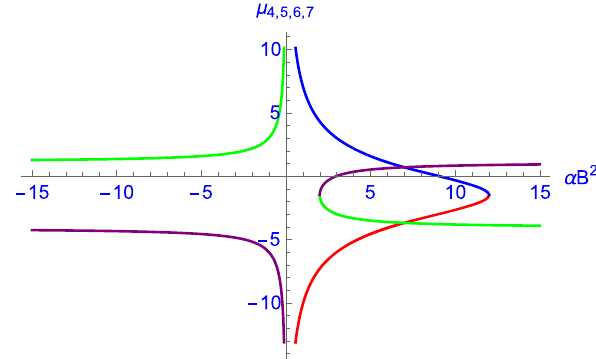
Fig. 2 Eigenvalues μ 4 (red), μ 5 (blue), μ 6 (green), and μ 7 (purple) as functions of α B